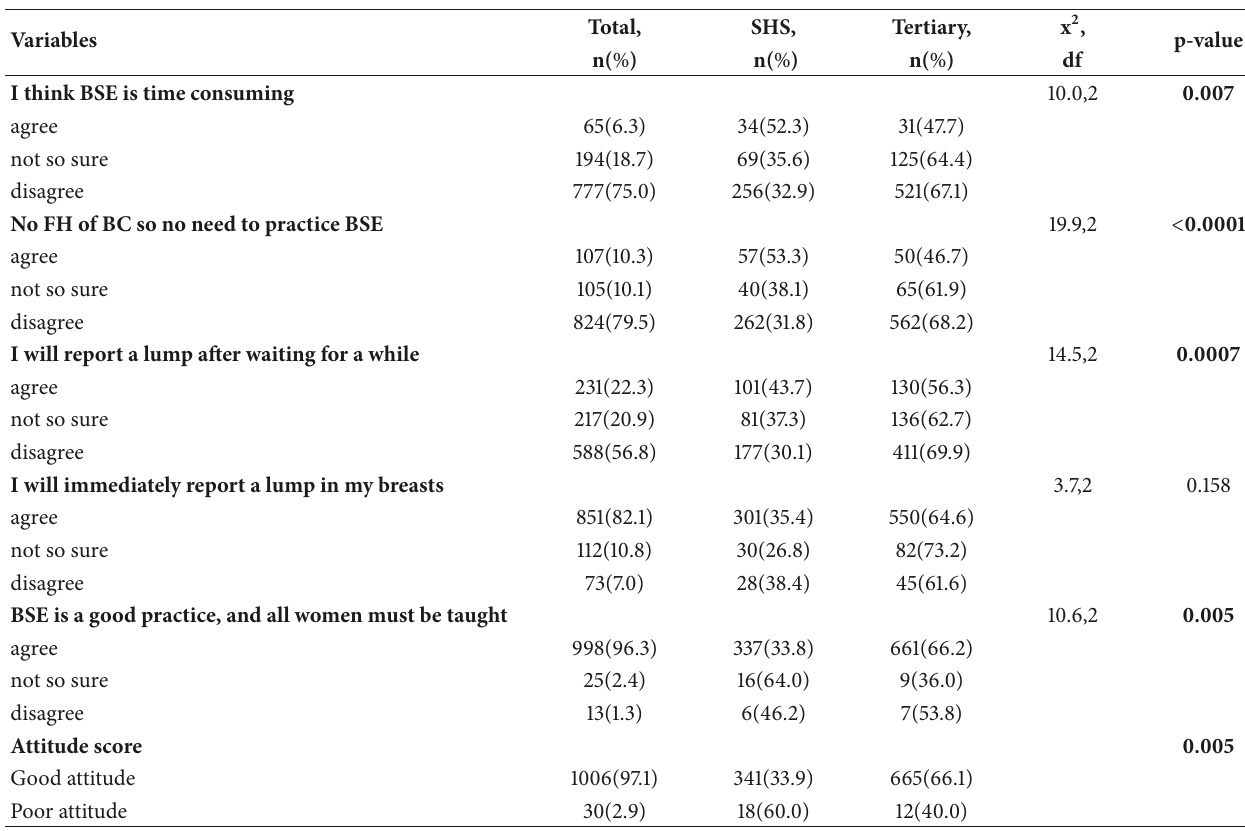
Table 4: Participants attitudes towards BSE stratified by their educational